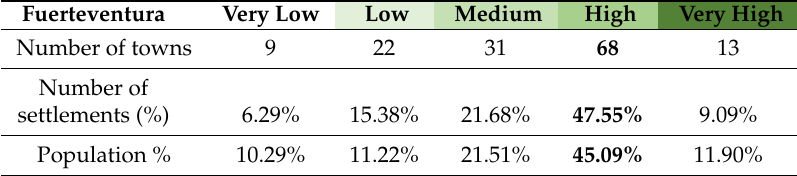
Table 3. Outcomes regarding the accessibility levels in the Island of Tenerife (Source: